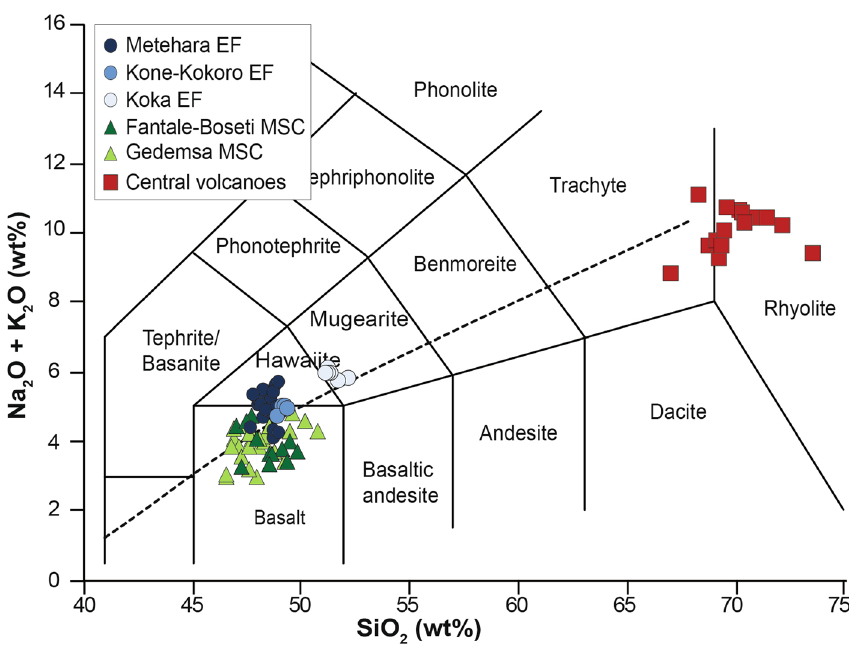
Figure 4. Total alkali silica (TAS) diagram of analysed products. Total alkali vs. silica (TAS) diagram for monogenetic scoria cones (MSC), eruptive fissures (EF) and central volcanoes products. Whole-rock compositions for MSC of the Gedemsa area have been also included 40,41